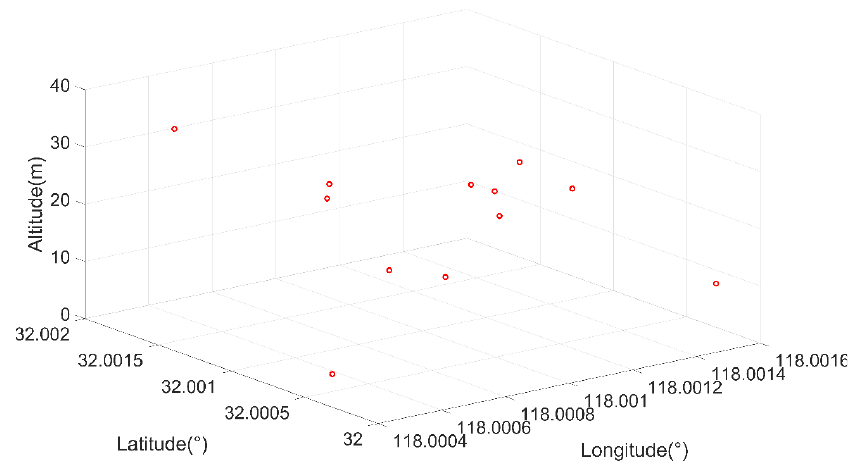
Figure 4. The initial positions of the UAV swarm.